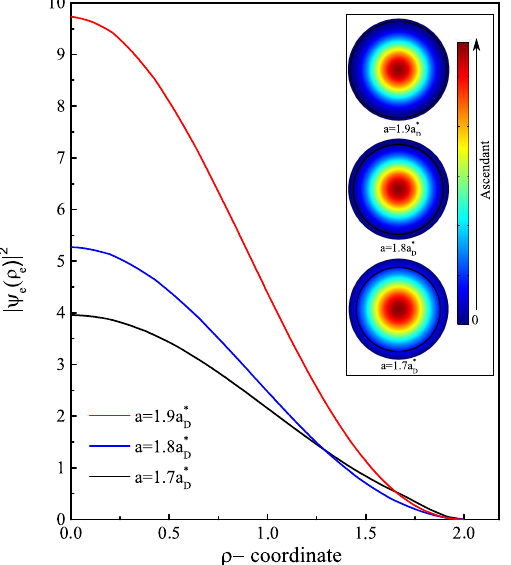
Figure 4. Electron probability density in Al x Ga 1 − x As/GaAs core/shell NW along the radial direction ρ at zero magnetic field ( γ = 0). Three core radius values are considered a = 1.7,1.8 and 1.9 a ∗ than the threshold radius a 0 . Each linear representation corresponds to the planar representation, which is the xy-plane cross-section of the electron density distribution at the middle of the cylinder.